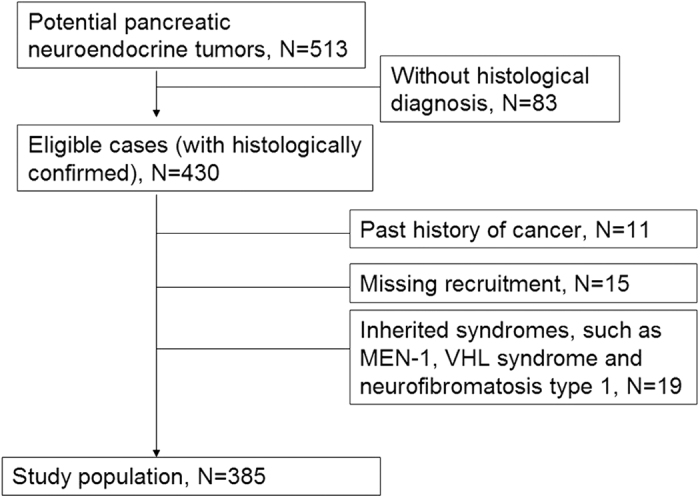
Flowchart of patient selection.